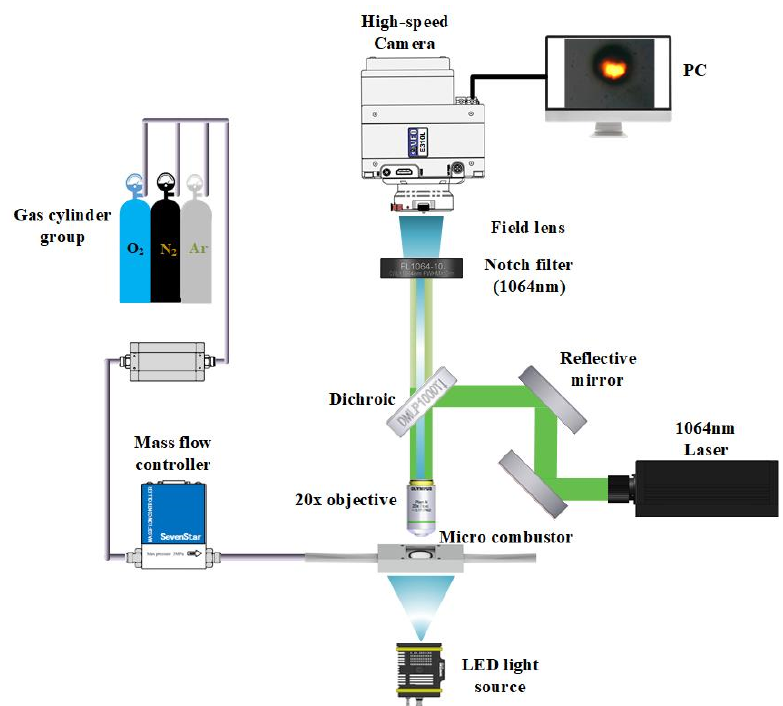
Figure 2. Schematic of experimental apparatus.